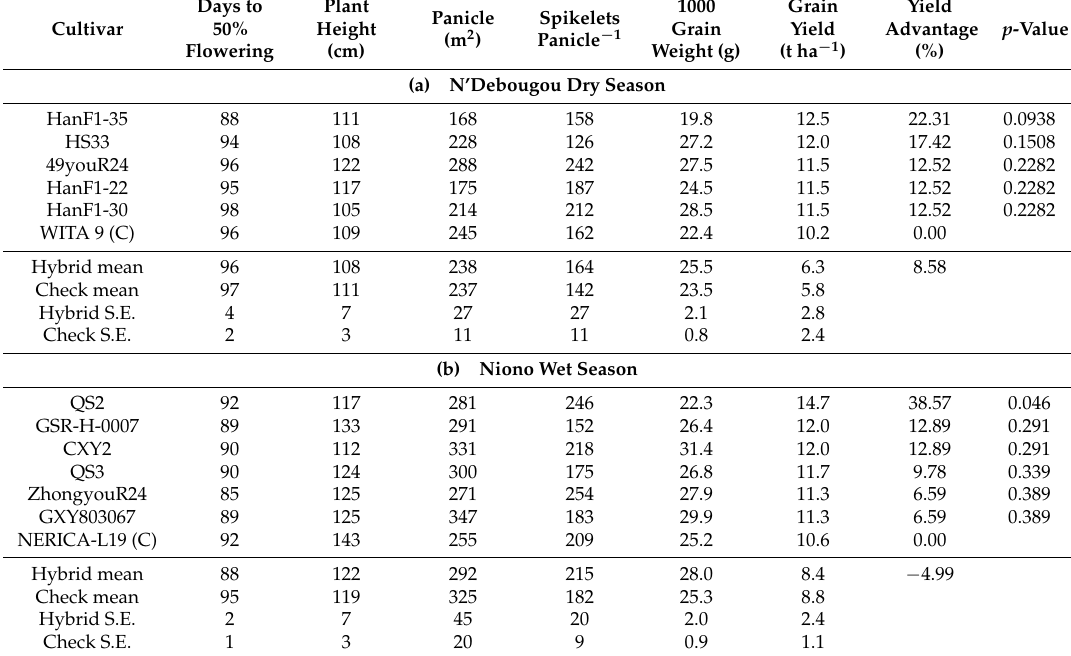
Table 3. Grain yield and other agronomic traits of promising rice hybrids and best cultivar check (C) in 2010 at ( a ) N’Debougou, Mali dry season and ( b ) Niono, Mali wet season. The p -value indicates that hybrids’ yield was significantly higher that WITA 9 and NERICA-L19. Standard errors (S.E.) given for each